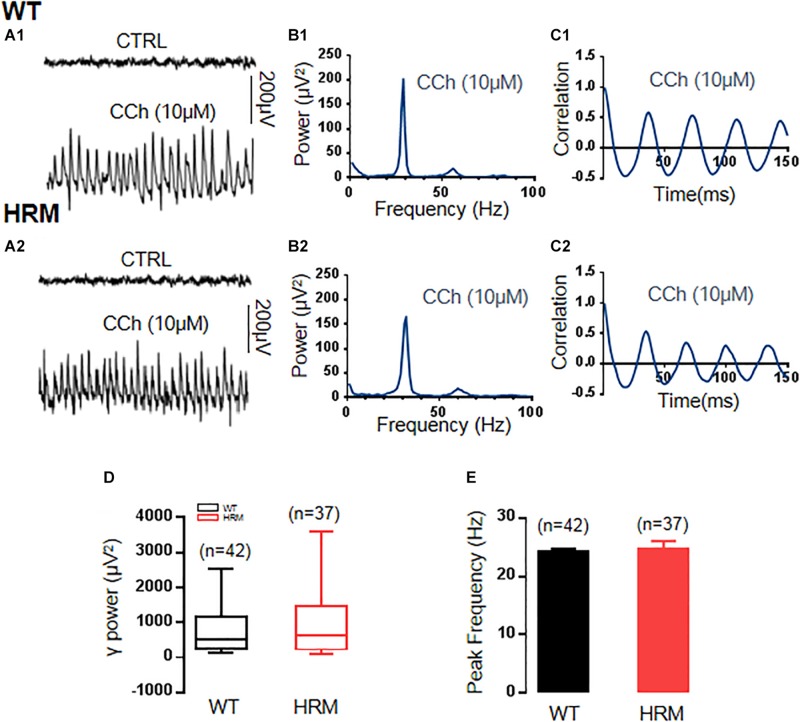
γ power in hippocampal CA3 region in wild-type mice (WTM) and heterozygous reeler mice (HRM). (A1,A2) The original curve of 1-s field potential induced by carbachol (CCh) recorded in the hippocampal CA3 region in WTM (A1) and HRM (A2) hippocampal slices. (B1,B2) The power spectrum of field potential induced by CCh from WTM (B1) and HRM (B2) hippocampal slices. (C1,C2) Autocorrelograms of the recordings in A1 and A2 show the oscillation regularity of CCh-induced oscillations from WTM (C1) and HRM (C2). (D) The bar graph shows the values of γ power of CCh-induced oscillations in WTM and HRM. (E) The peak frequency of CCh-induced oscillations in WTM and HRM.